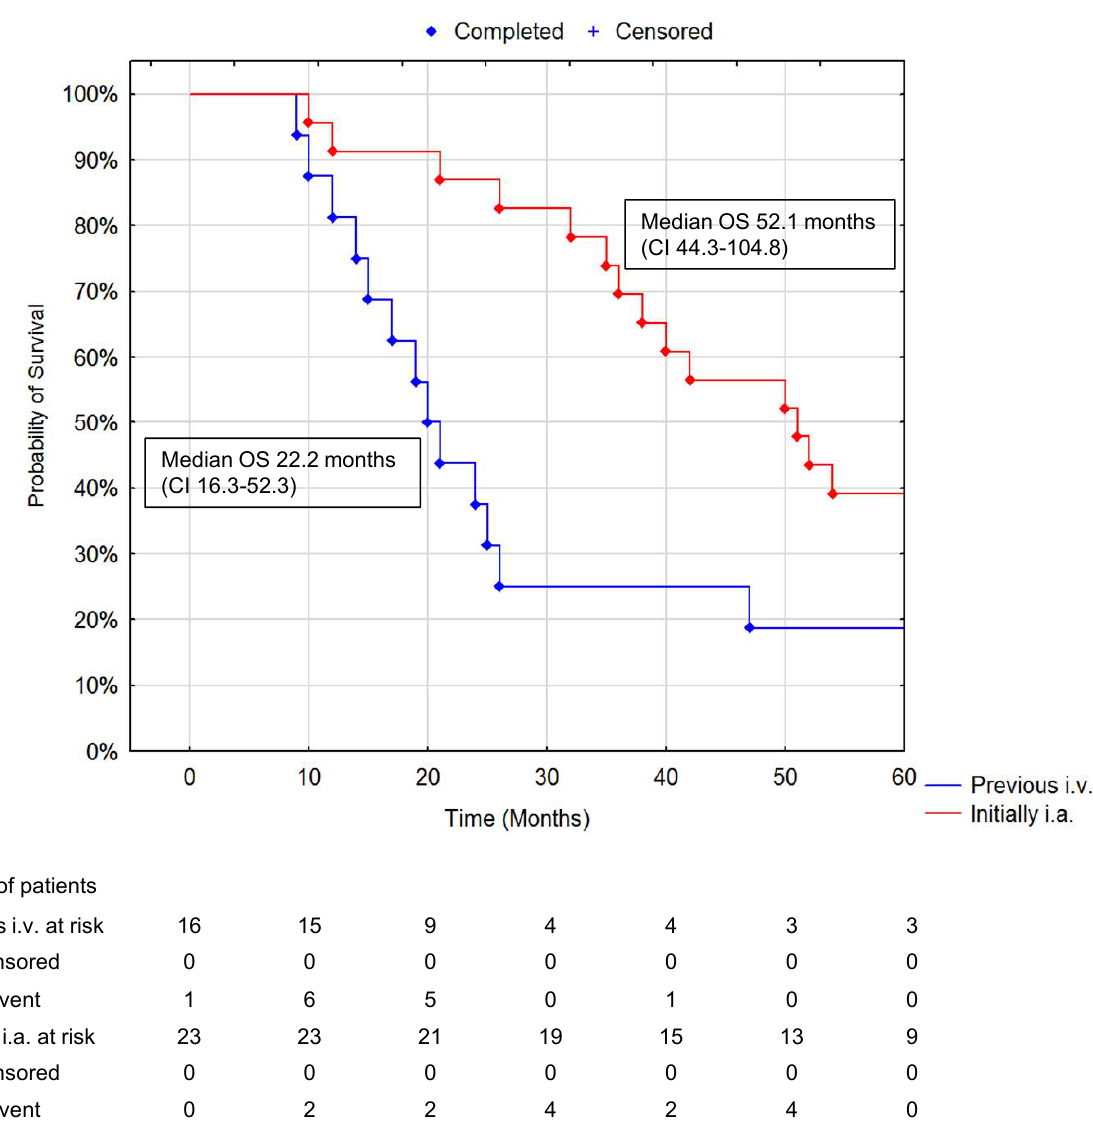
Figure 5. Comparison of OS in patients with previous i.v. PRRT and initially i.a. PRRT median 22.2 (CI 16.3–52.3) vs. 52.1 (CI 44.3–104.8) ( p = 0.02 Cox Mantel Test). The number of subjects remaining at risk is below 10% of cases in any